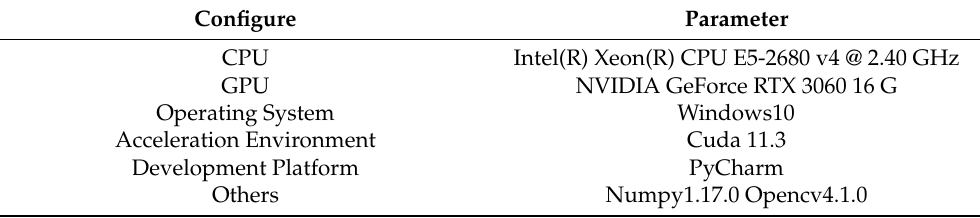
Table 1. Test environment.